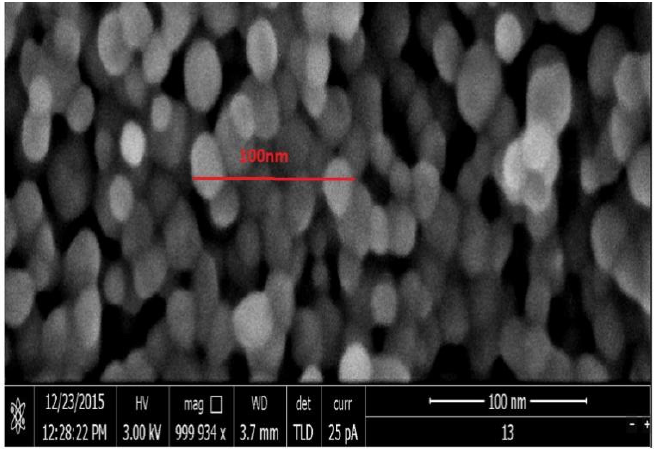
Figure 2. Growth morphology of nano TiO 2 .